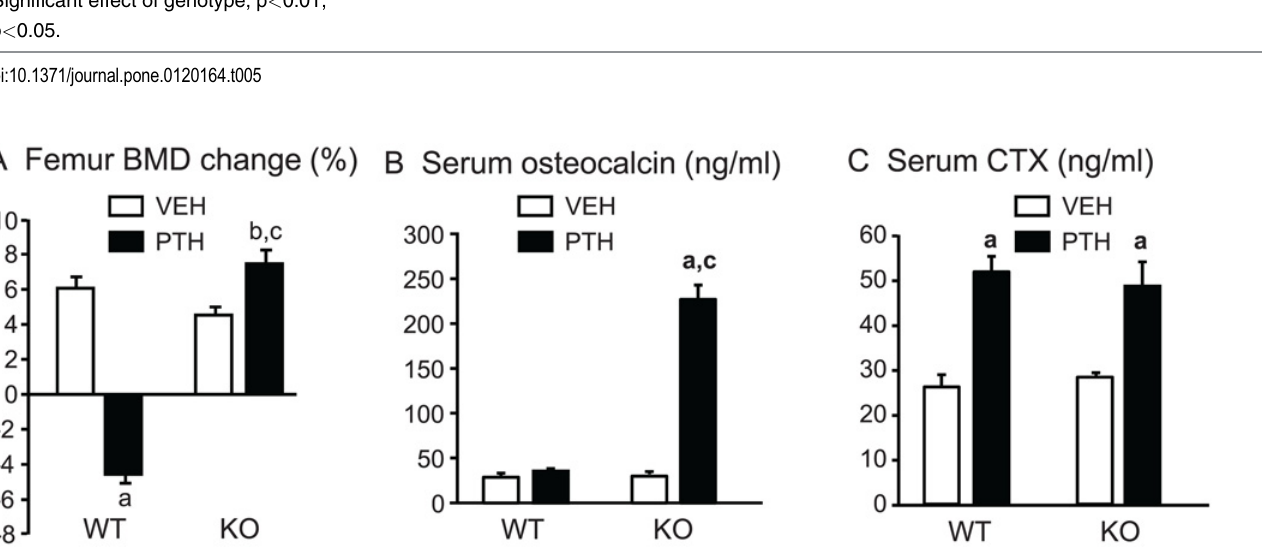
Fig 5. Femoral BMD and serum markers of bone turnover in mice infused for 21 days. A. BMD was measured in vivo at beginning and end of infusion with vehicle or PTH in WT and Cox2 KO mice and the percent change calculated relative to the beginning BMD for each mouse. B, C. Serum parameters for bone formation (osteocalcin) and bone resorption (CTX) were measured at the end of study. Bars are means ± SEM for 6 WT and 6 KO mice infused with vehicle and 7 WT and 7 KO infused with PTH. a Significant effect of PTH, p < 0.01; b p < 0.05. c Significant effect of genotype, p <